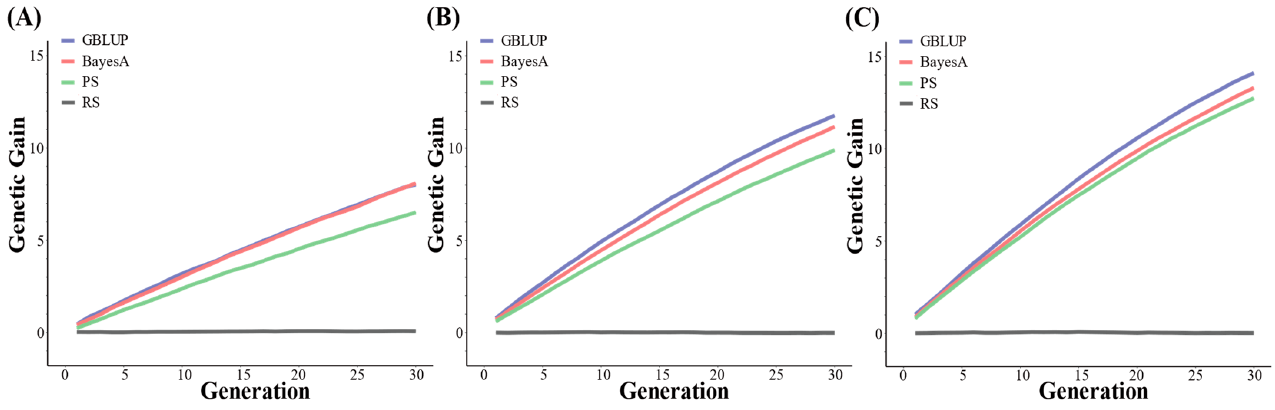
Figure 1. Genetic gains across 30 generations using 4 strategies with low, medium, and high heritability traits based on 54 K SNPs. ( A ) Genetic gains for trait heritability of 0.1. ( B ) Genetic gains for trait heritability of 0.3. ( C ) Genetic gains for trait heritability of 0.5.